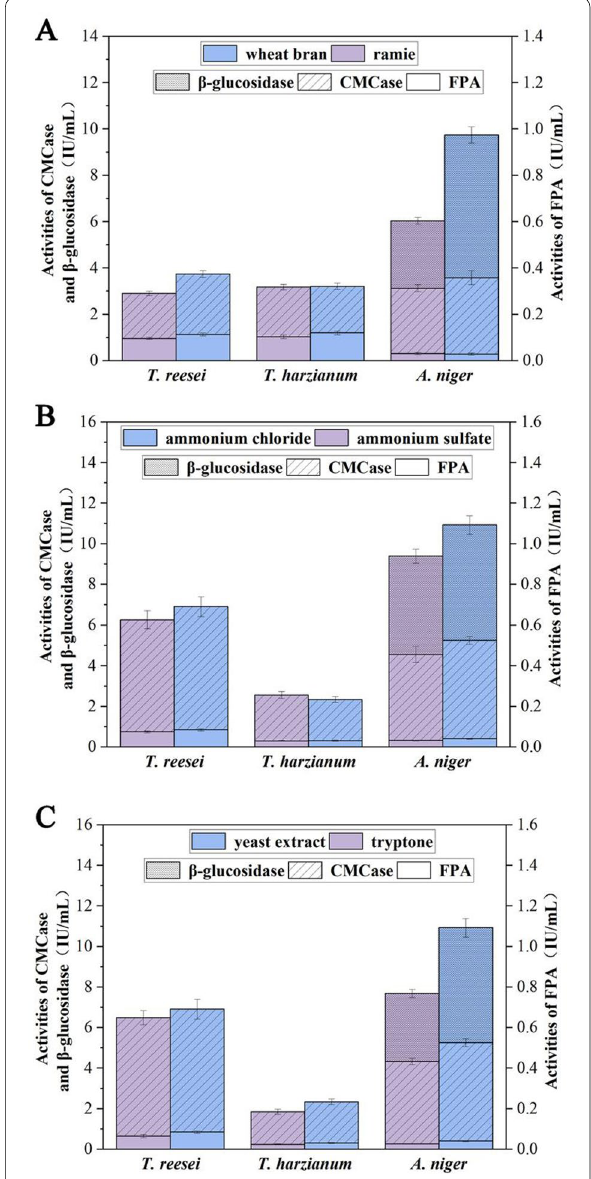
Fig. 1 The effects of different sources of carbon ( A ), inorganic ( B ) and organic ( C ) nitrogen on the production of cellulases by different fungi